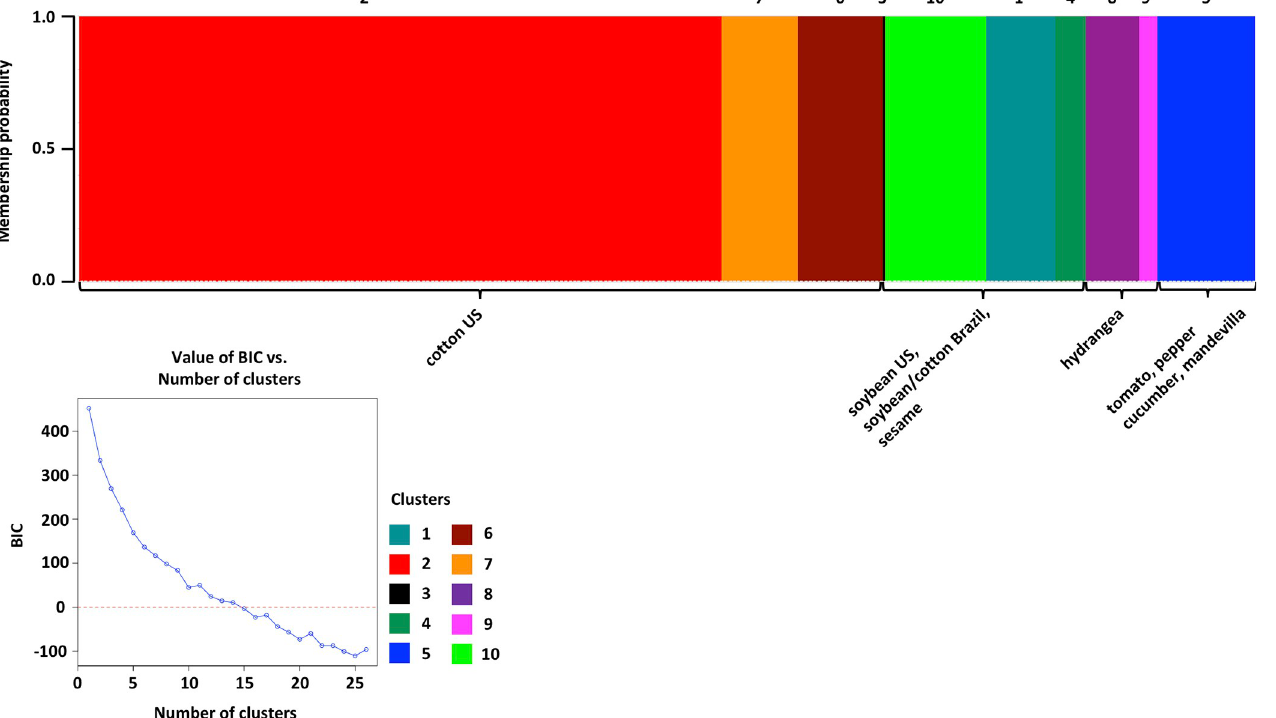
Fig 2. Histogram of assignment probability of 265 Corynespora cassiicola isolates to clusters based on discriminant analysis of principal components (DAPC). Each bar represents a single isolate and the color shown indicates the predicted cluster composition in proportion to the bar size. Additionally, numbers are above the histogram to indicate each cluster. The Bayesian information criterion (BIC) for each K value is shown in the lower left corner.